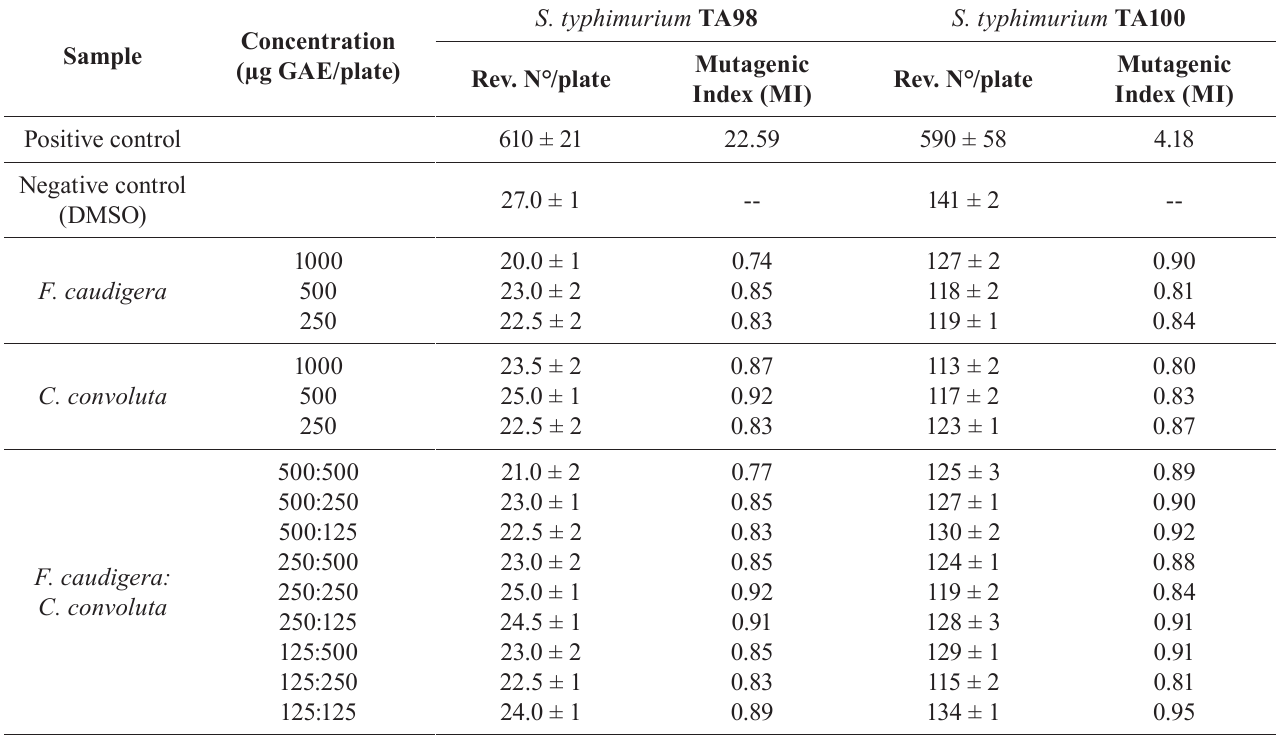
Data correspond to the mean ± DE of three